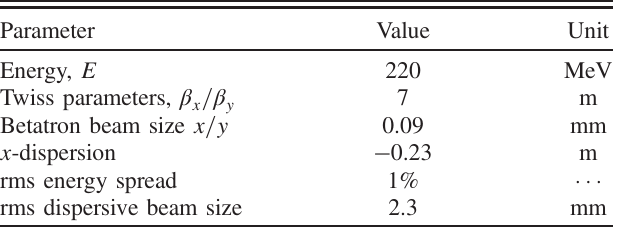
TABLE I. Twiss and beam parameters at the LCLS BC1 chicane center.